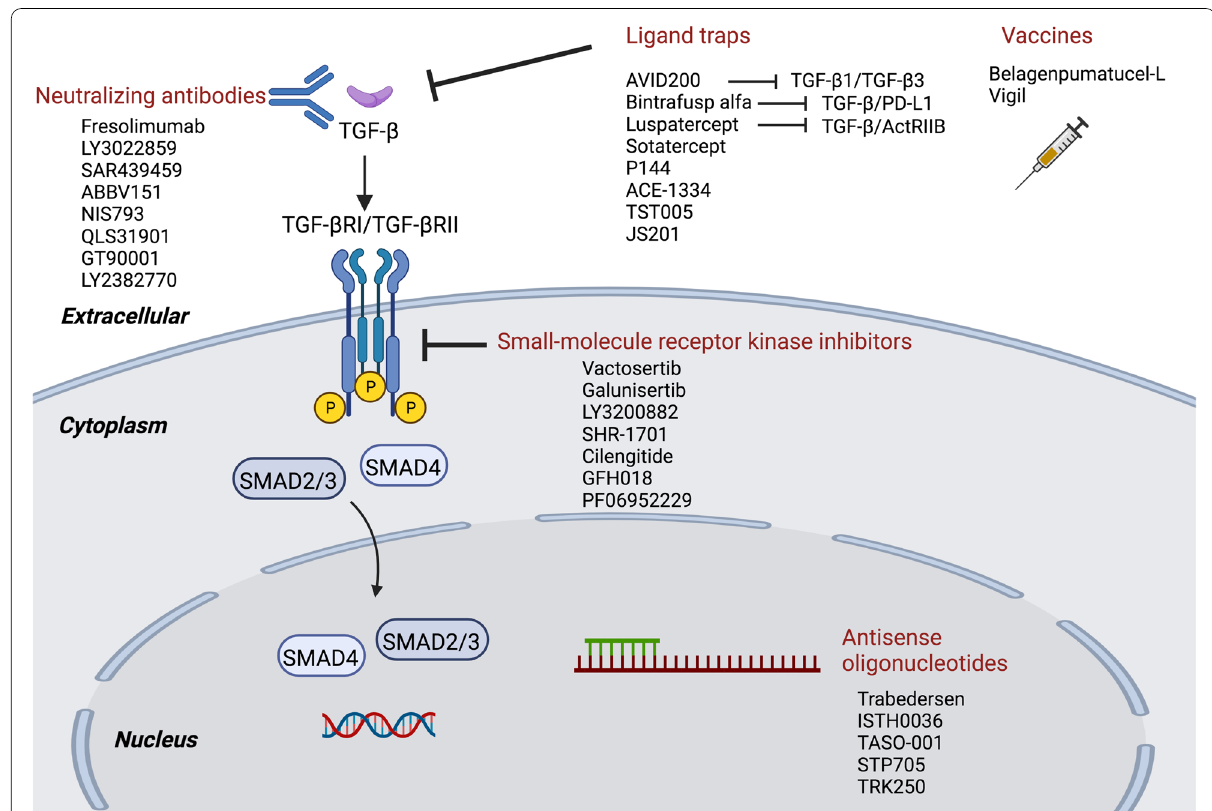
Fig. 5 Potential therapeutic strategies based on the TGF-β signaling pathway in disease. Antagonists targeting the TGF-β pathway, including neutralizing antibodies, ligand traps, small-molecule receptor kinase inhibitors, antisense oligonucleotides and vaccines, have recently been evaluated in clinical trials. Representative drugs are